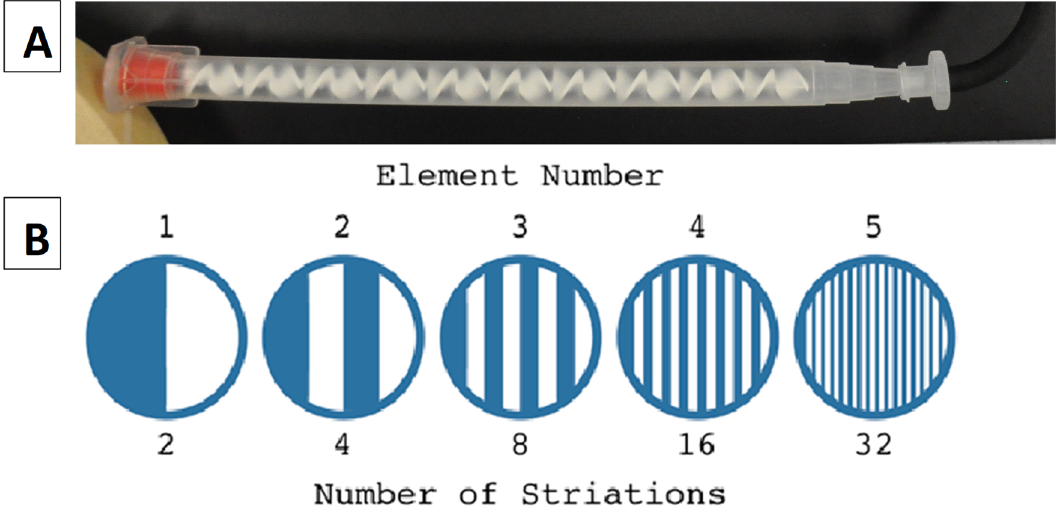
Figure 1. Static mixing device and principle. ( A ): Image of a single-use commercial (Loctite) static mixer, 10 × 150 mm. ( B ): Depiction of interfacial surface generation (ISG) downstream of each baffle in sequence.